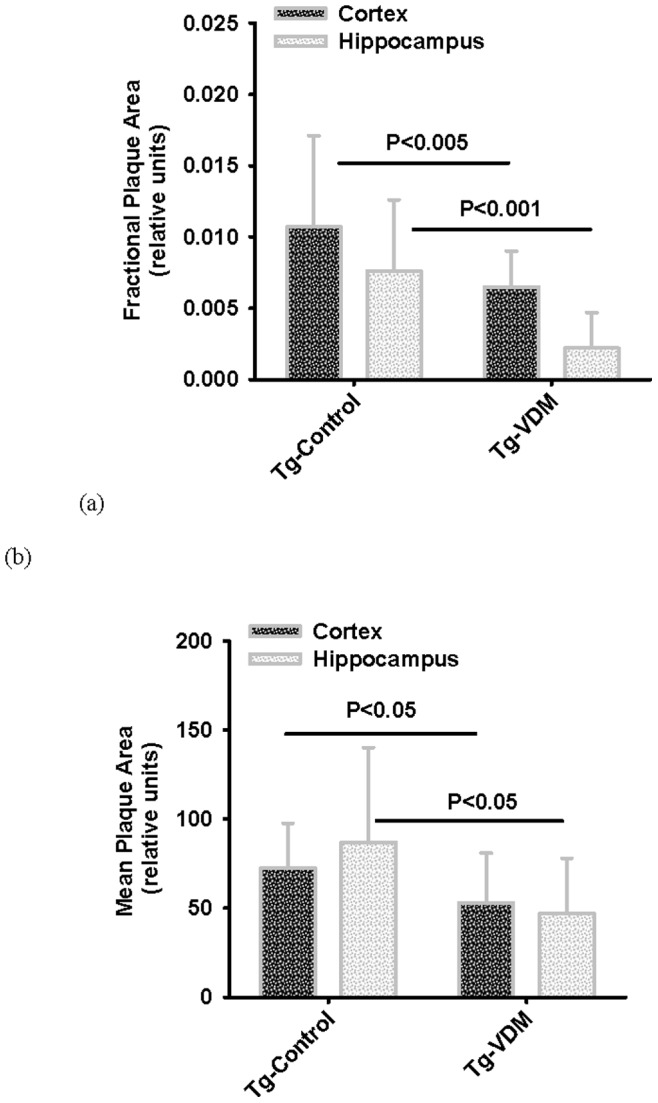
Quantification of brain amyloid plaque loads in transgenic mice groups at 9 months.Relative levels of brain plaque measured at 9 months, by immune-histochemical staining with 1E8 antibody to Aβ42 assessed by image analysis, showing (a) fractional coverage of plaque per total areas of cortex or hippocampus and (b) mean plaque areas in respective brain regions. Results are averaged across brains of n = 12 or 13 mice and are shown as average for the group with standard deviation. All P values were determined using Student’s T-test.